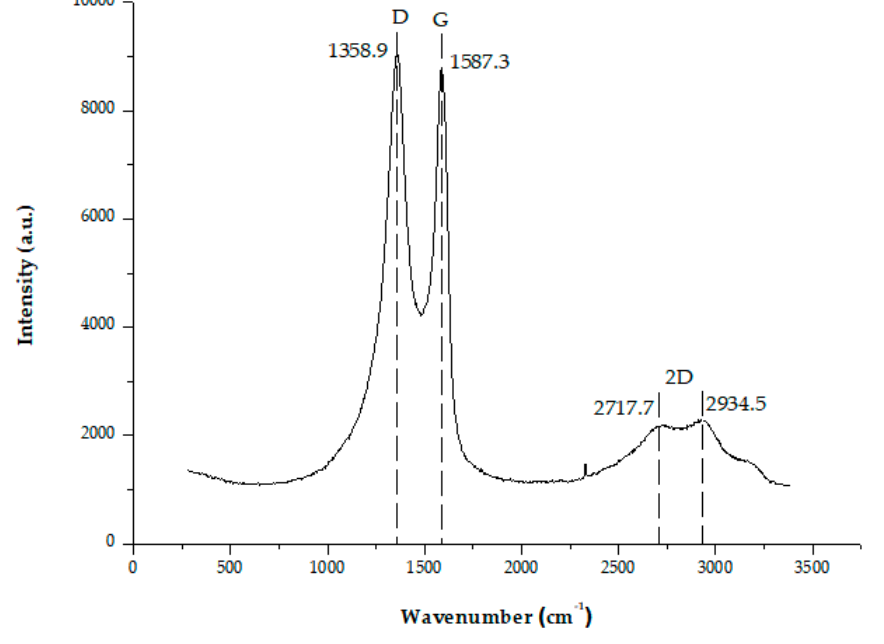
Figure 4. Raman spectra of GO colloid Figure 4 . Raman spectra of GO colloid solution.